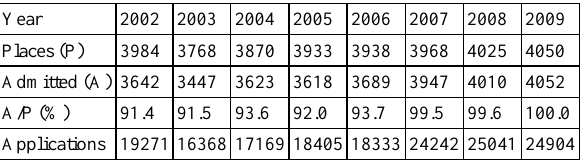
TABLE III. S TATISTICS OF THE 1 ST PHASE OF APPLICATION TO U.P ORTO FOR 1 ST YEAR